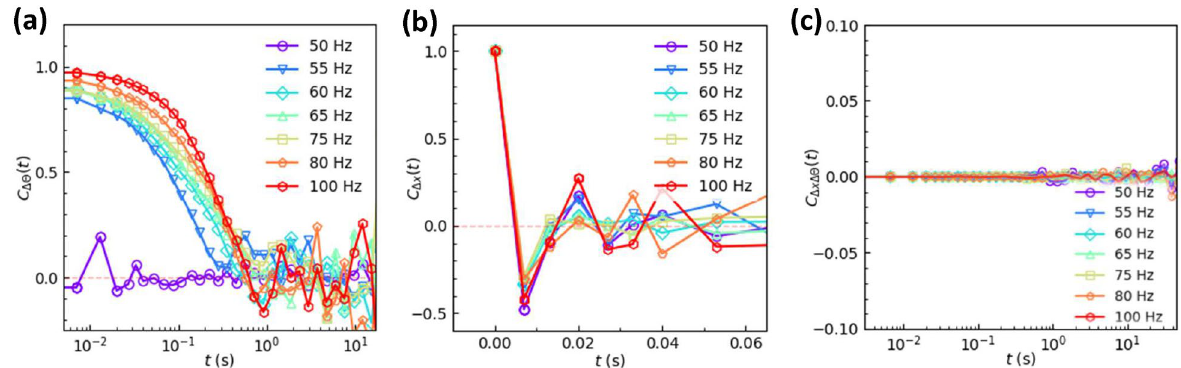
6.0, 8.7, 15.5 , and 24.0. =